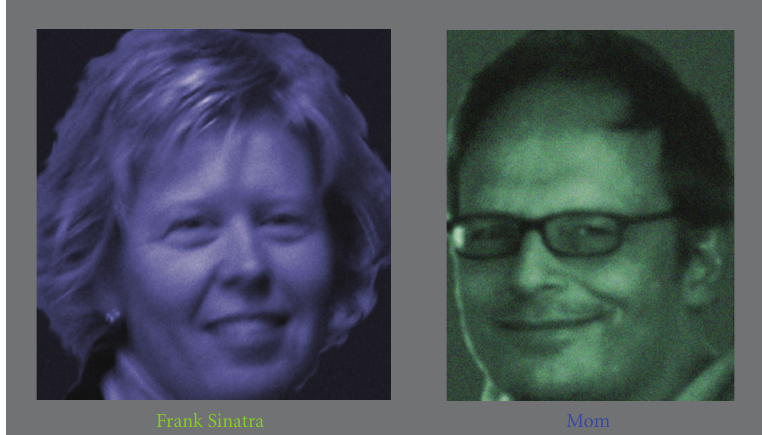
Figure 1: Examples of photos and names displayed during fMRI data